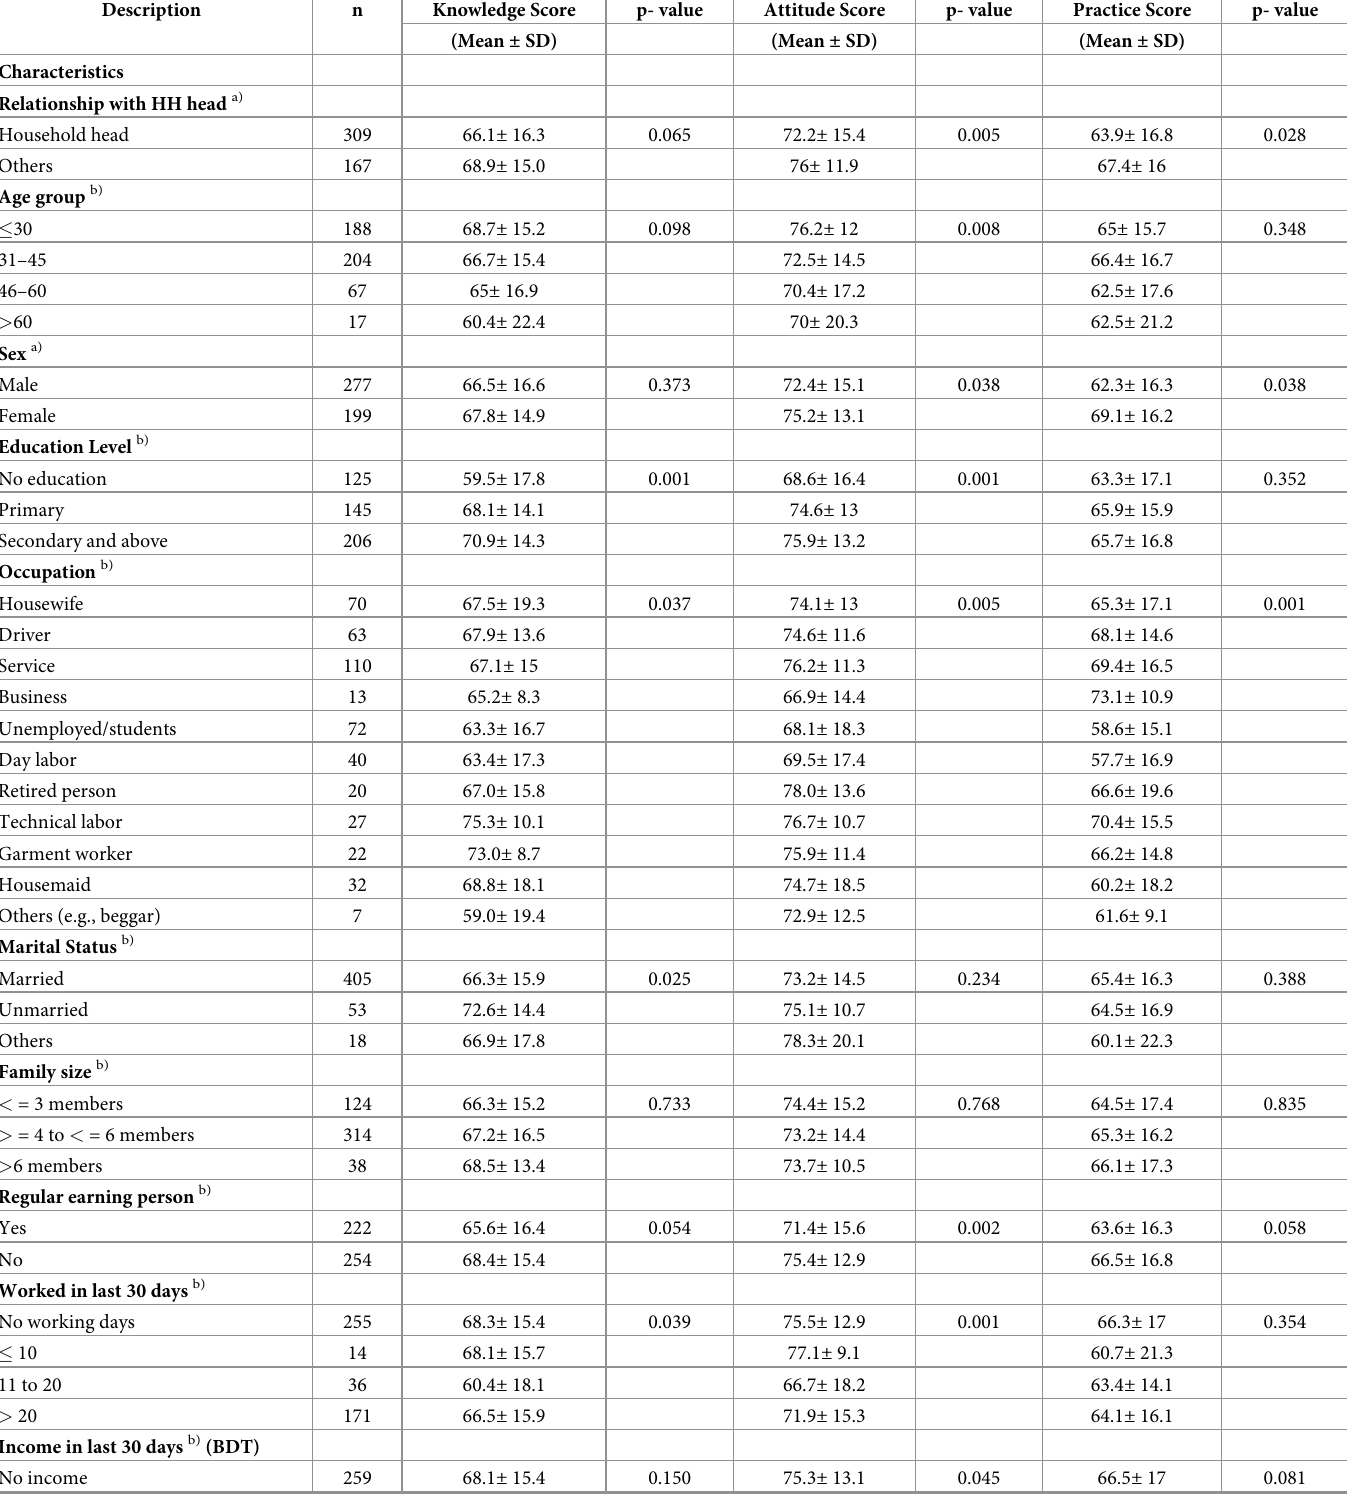
Table 5. Average level of knowledge, attitude, and practice scores towards COVID-19 by the demographic and socioeconomic characteristics of respondents.